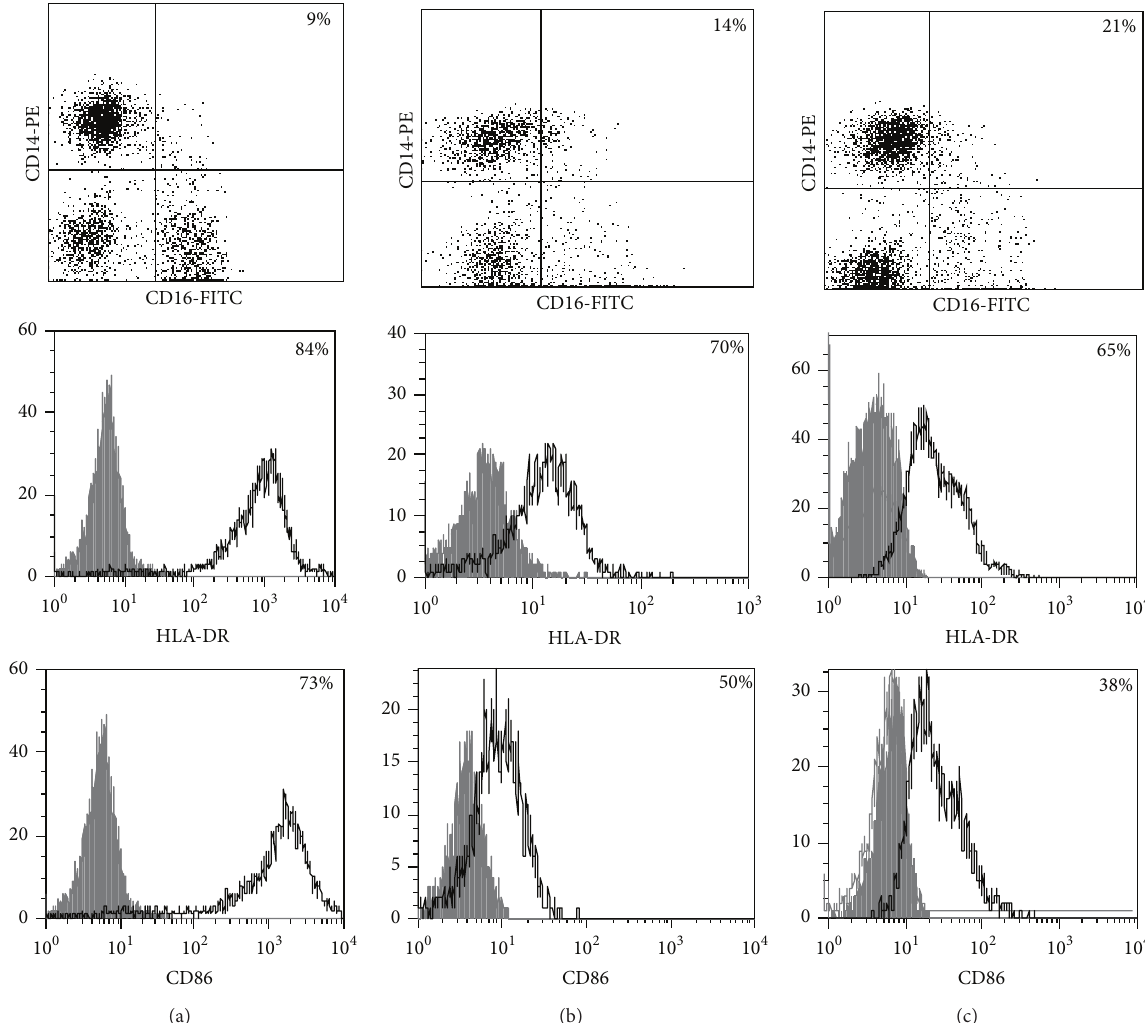
Figure 1: Surface antigen expression on circulating monocytes obtained from peripheral blood of TB patients (a), PPD-reactive (b) and PPD- anergic (c) TB patients. Open histogram represents stained cells (patient Mo) and the filled histogram represents isotype specific control.